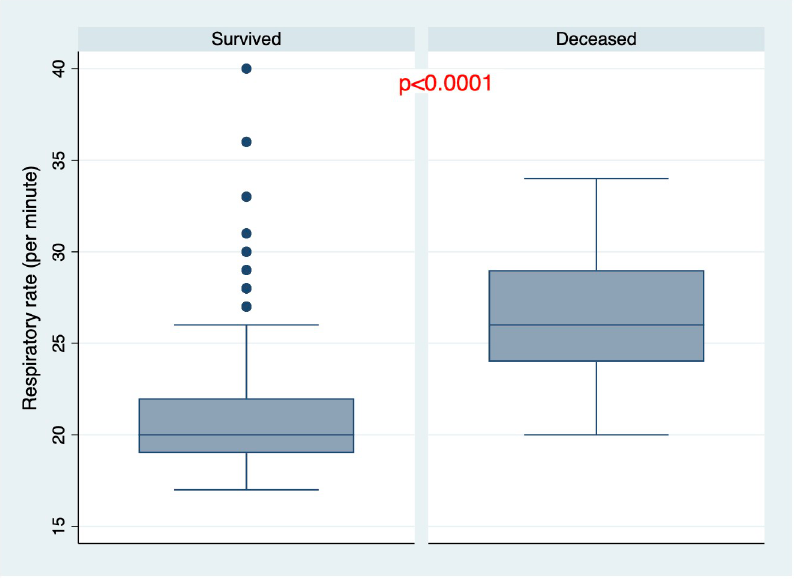
Fig 4. Respiratory rate distribution among survived and deceased patients.